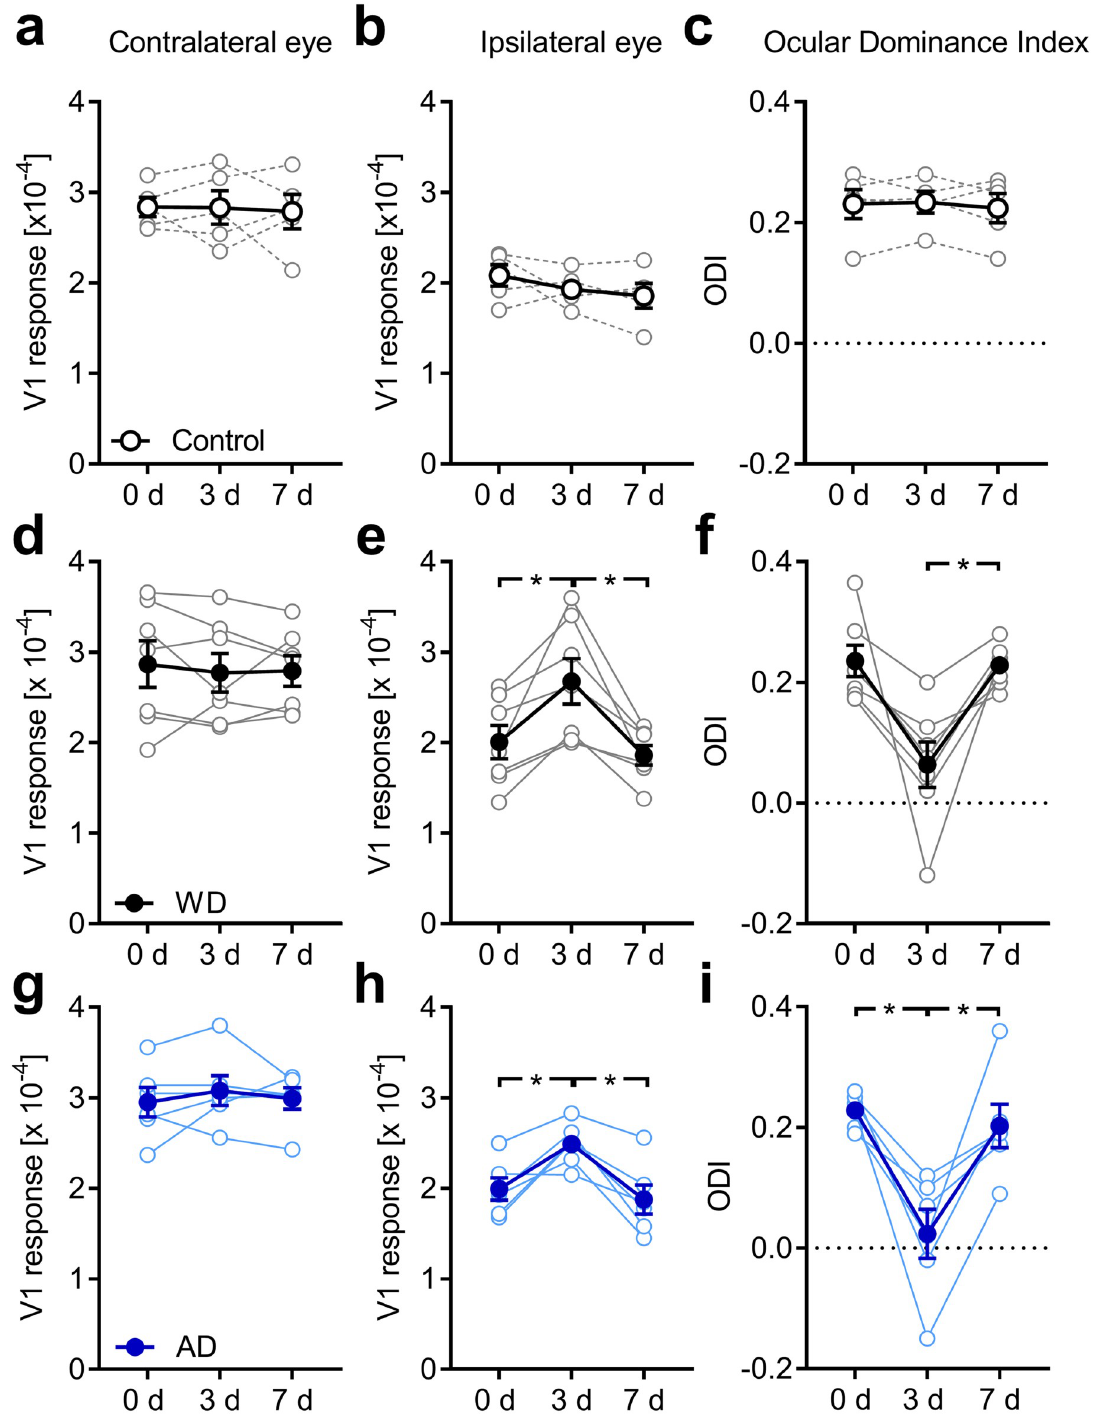
Fig 3. Both WD and AD shift OD in the binocular V1 in fully adult mice. ( a, b ) V1 activity evoked by visual stimulation of the contra or ipsilateral eye in untreated control mice (n = 5) remained unchanged at 0, 3 and 7 days. ( c ) Thus, over the same time course the ODI did not change underlining the reliability of repeated intrinsic signal imaging. ( d ) During one week after WD (n = 7), V1 activity elicited by contralateral eye stimulation was unaltered. ( e ) However, V1 responsiveness to ipsilateral eye stimulation markedly increased 3 days after WD followed by a recovery of V1 activity 7 days after WD. ( f ) These alterations of V1 responsiveness led to an ODI shift towards zero at day 3 which was followed by a readjustment of the ODI 7 days after WD. ( g ) After AD (n = 6) V1 activity elicited by contralateral